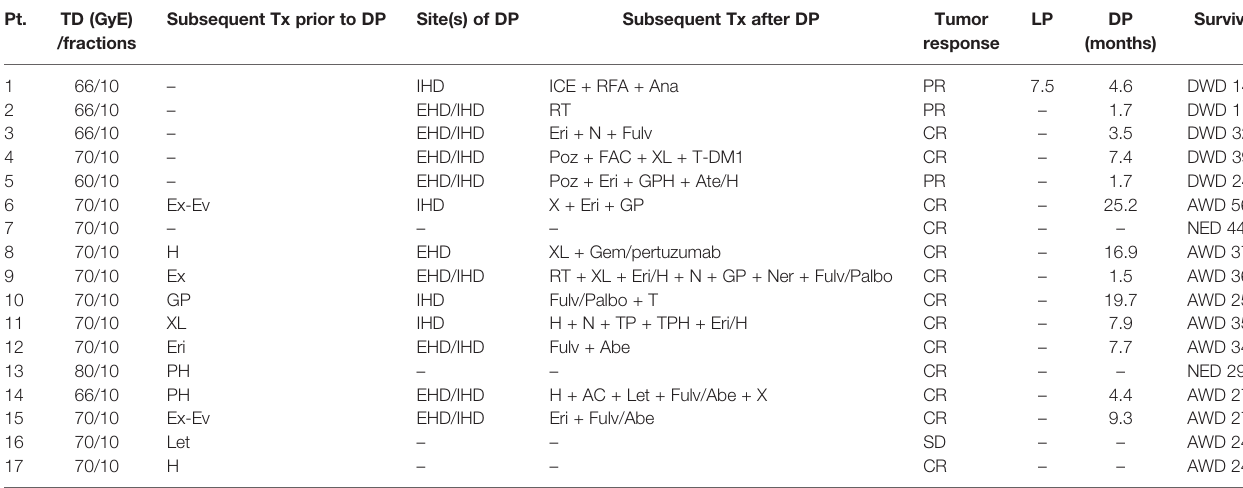
TABLE 2 | Treatment details and outcomes of patients with liver metastasis from breast cancer receiving proton beam therapy. Pt.